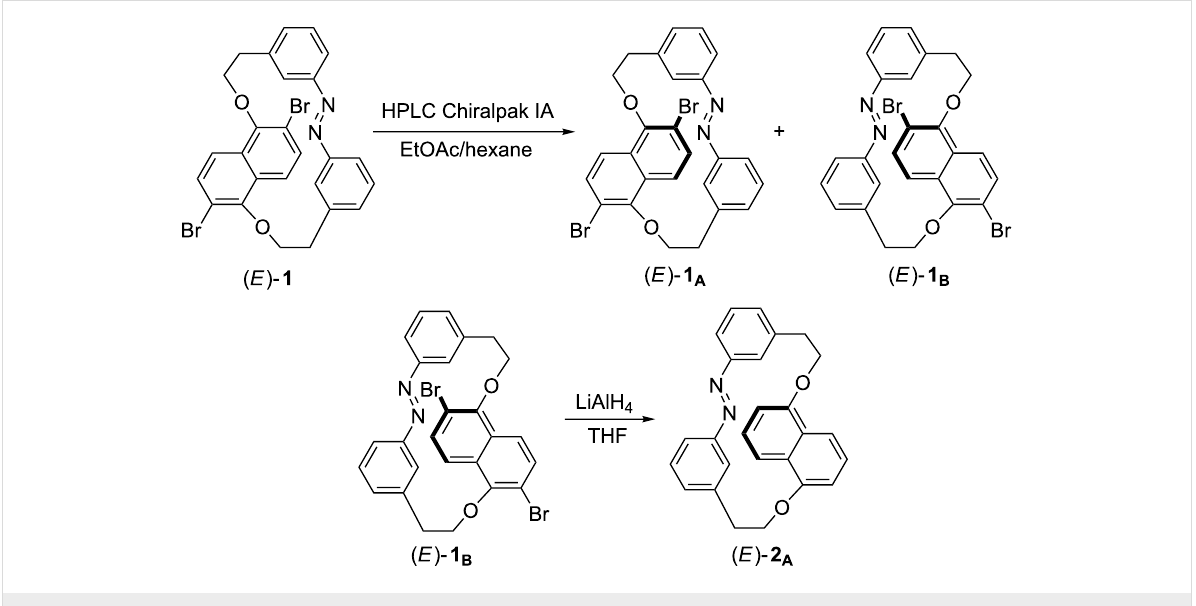
Figure 1: Schematic representation of the steps to enantiomer ( E )- 2 A .